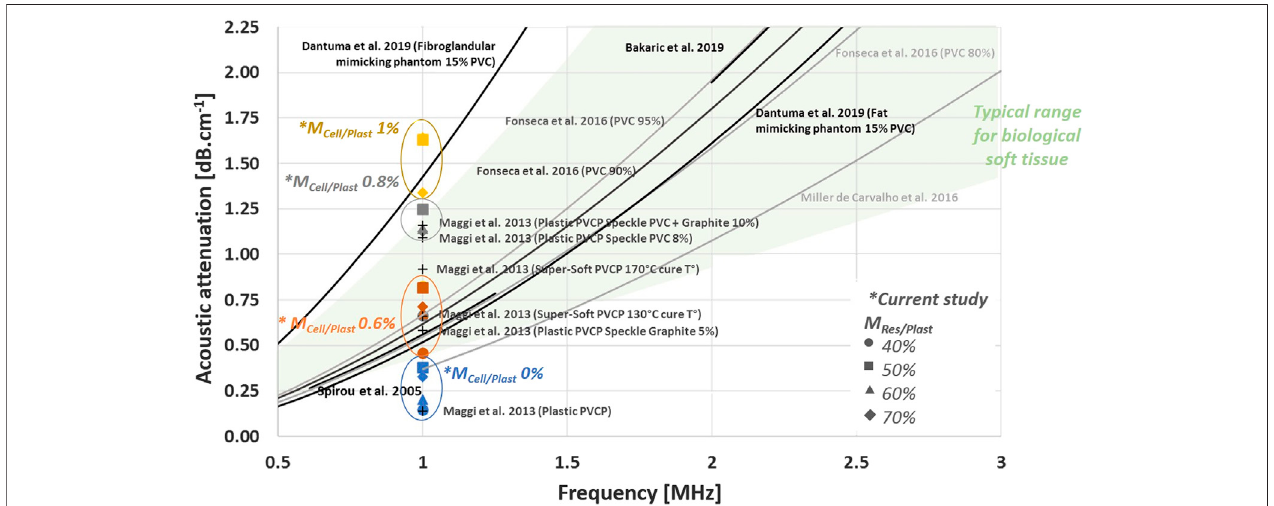
FIGURE 1 | The acoustic attenuation coef fi cients measured at 1 MHz in the tested Plastisol phantoms (colored signs) are compared to typical values from the literature for biological soft tissues (green colored area) [44] and to similar PVCP TMP (gray and black curves) [30, 32, 33, 35, 40, 51, 52] over the acoustic frequency range 0.5 – 3